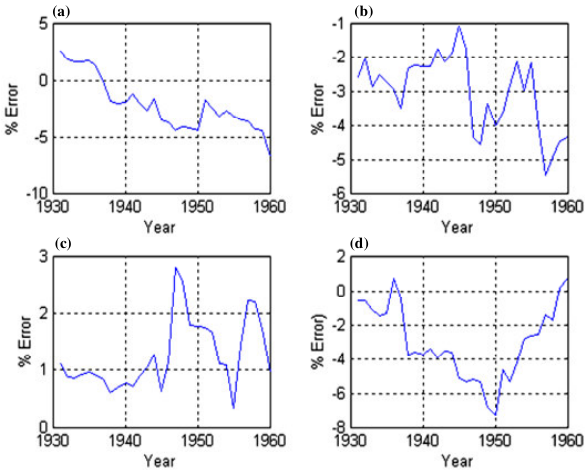
Fig. 12. Error Distribution for (a) October (b) April (c) May (d) July.